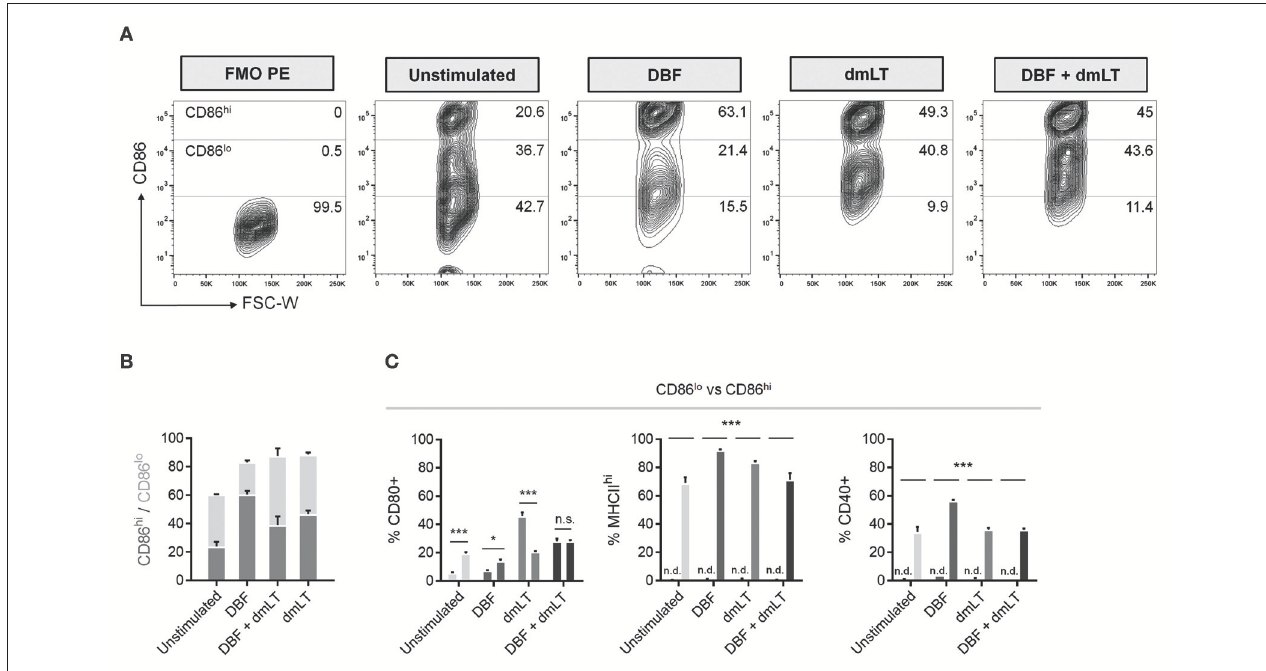
FIGURE 3 | Differences in CD86 lo and CD86 hi DC populations. (A) DC populations exposed to PBS, DBF, dmLT and the combination DBF + dmLT show a trimodal distribution of CD86. Differences in the abundance of the CD86hi population are evident across treatments, with an enrichment in antigen-treated DCs. Numbers provided are percentages of total population. (B) Distribution analysis of the CD86 + DC population. (C) Comparison between CD86 lo and CD86 hi populations for activation markers CD80, MHCII hi and CD40. CD80 is differentially distributed between the two populations, whereas all MHCII hi and CD40 + cells were also CD86 hi . Each bar represents the mean and SEM of duplicate biological samples. Statistical significance was analyzed with a 2-way ANOVA with a Sidak post-hoc test. All comparisons tested with an α value of 0.05. * p < 0.05, ** p < 0.01, *** p <